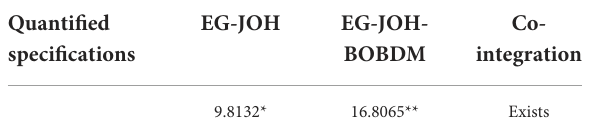
TABLE 8 Bayer and hank cointegration.